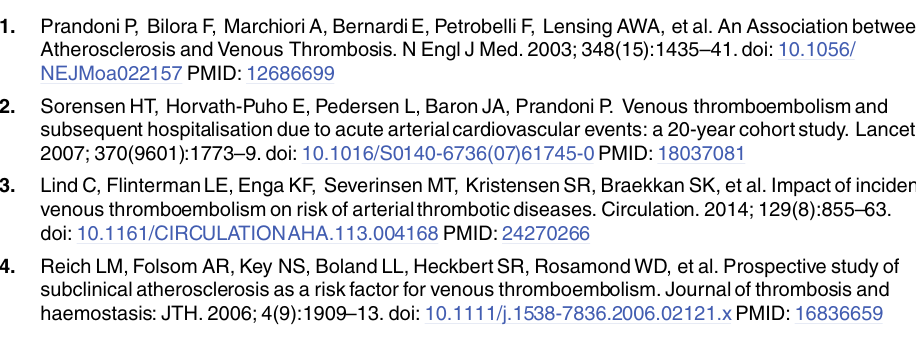
S1 Table. Distribution of traditional cardiovascularrisk factors in the different studies for participantswho participatedin all three studies (n =